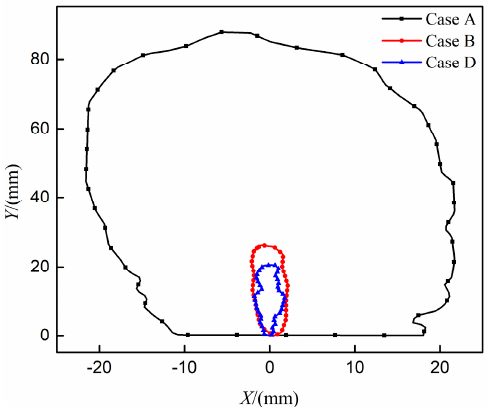
Figure 4. Recirculation zones of different air-blast atomizer structures.